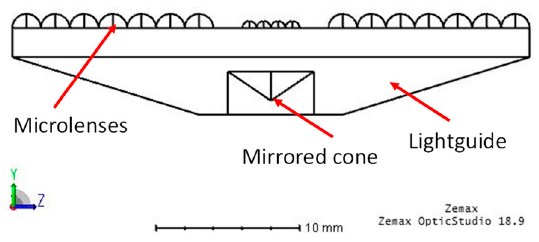
Figure 2. The 3D layout of the proposed lighting design in ZEMAX simulation software in the non-sequential mode.